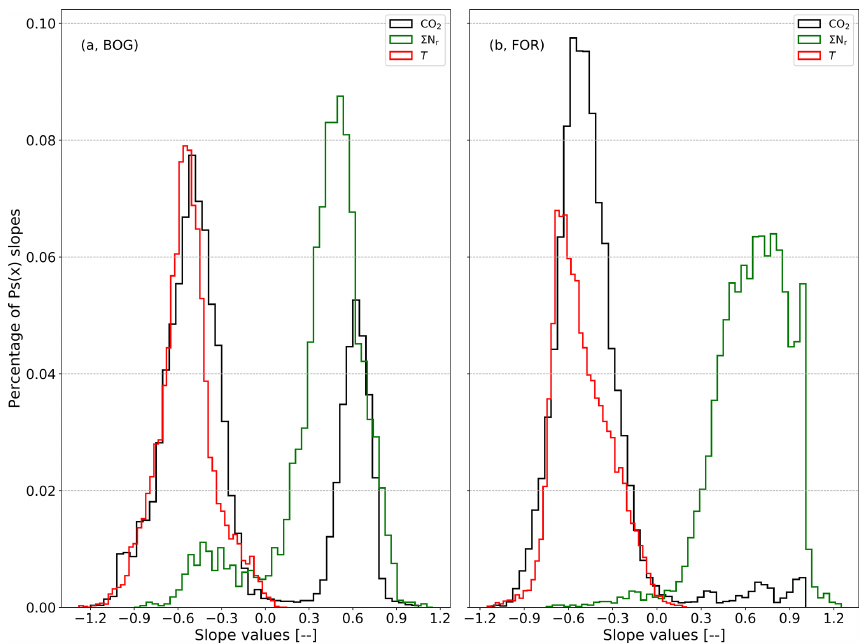
Figure 4. Distribution of spectral slopes in the high-frequency range ( > 0 . 1Hz) of Ps ((cid:54) N r ) (green), Ps ( CO 2 ) (black), and Ps (T ) (red) for the BOG site (a) and for the FOR site (b) . Slopes were estimated for half-hourly power spectra from 2 October 2012 to 17 July 2013 and from 1 June 2016 to 28 June 2018 at BOG and FOR,